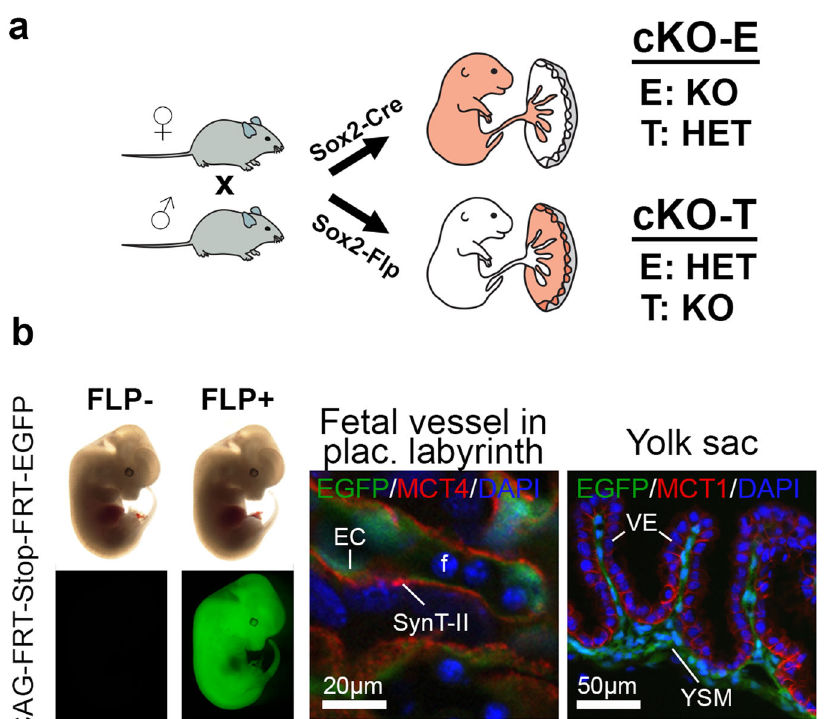
Fig. 3 | Conditionalknockout strategies todetermine causalityofpathologies. a Outline of Sox2 -Cre and Sox2 -Flp recombinase driver strategy to generate embryo-speci fi c (cKO-E) and trophoblast-speci fi c (cKO-T) knockouts (see